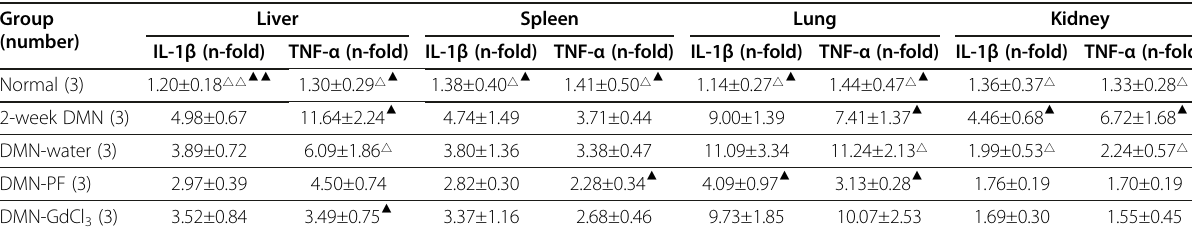
Table 4 Effects of PF on transcript levels of proinflammatory cytokines TNF- α and IL-1 β in different organs in DMN-induced rat liver fibrosis ( (cid:1) x ± s) Group Liver Spleen Lung (number)